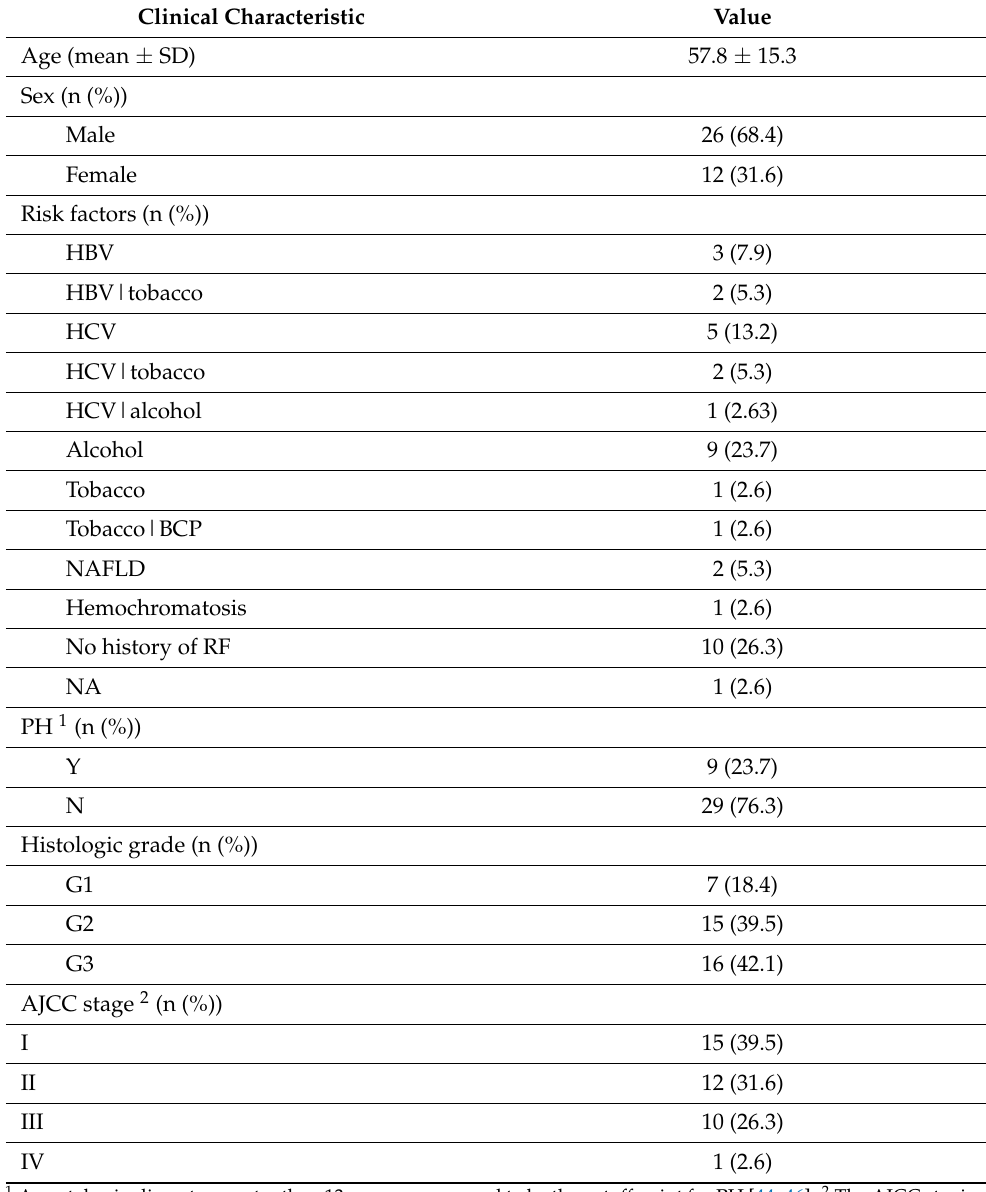
Table 1. Characteristics of included patients. Abbreviations: SD, standard deviation; HBV, hepatitis B; HCV, hepatitis C; NAFLD, non-alcoholic fatty liver disease; BCP, birth control pills; RF, risk factors; PH, portal hypertension; Y, yes; N, no; G1, well-differentiated HCC; G2, moderately differentiated HCC; G3, poorly differentiated HCC; NA, not assessed; AJCC, American Joint Committee on